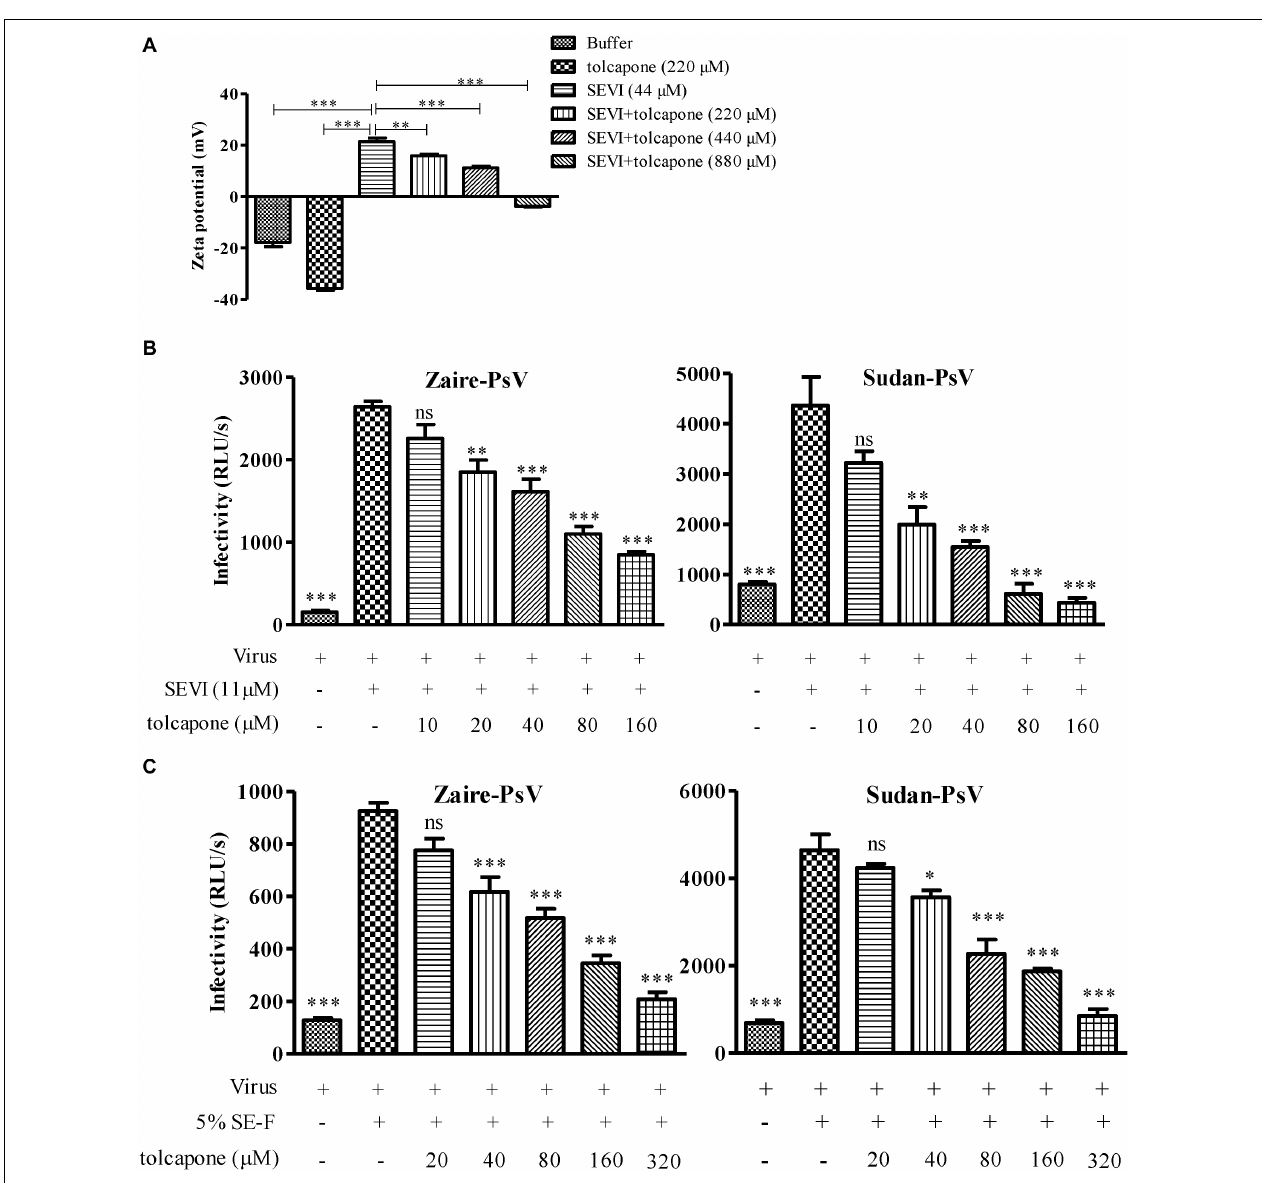
FIGURE 5 | Tolcapone modifies the surface charge of semen-derived enhancer of viral infection (SEVI) and blocks amyloid-induced enhancement of viral infection. (A) Zeta potential of SEVI fibrils in the presence or absence of tolcapone. The results are the average values ± SD ( n = 3). ∗ p < 0.05; ∗∗ p < 0.01; ∗∗∗ p < 0.001; one-way ANOVA. SEVI (B) or agitated seminal fluid (SE-F) (C) was incubated with tolcapone at the indicated concentrations or phosphate buffered saline (PBS) for 15 min at 37 ◦ C. The mixtures were centrifuged, and the pellets were then incubated with Zaire-pseudovirus (PsV) (left panel) or Sudan-PsV (right panel), respectively. Infection of HeLa cells by measuring luciferase activity as described above 72 h post-infection. The data represent the mean ± SD of three independent experiments. ∗ p < 0.05; ∗∗ p < 0.01; ∗∗∗ p < 0.001; one-way ANOVA.